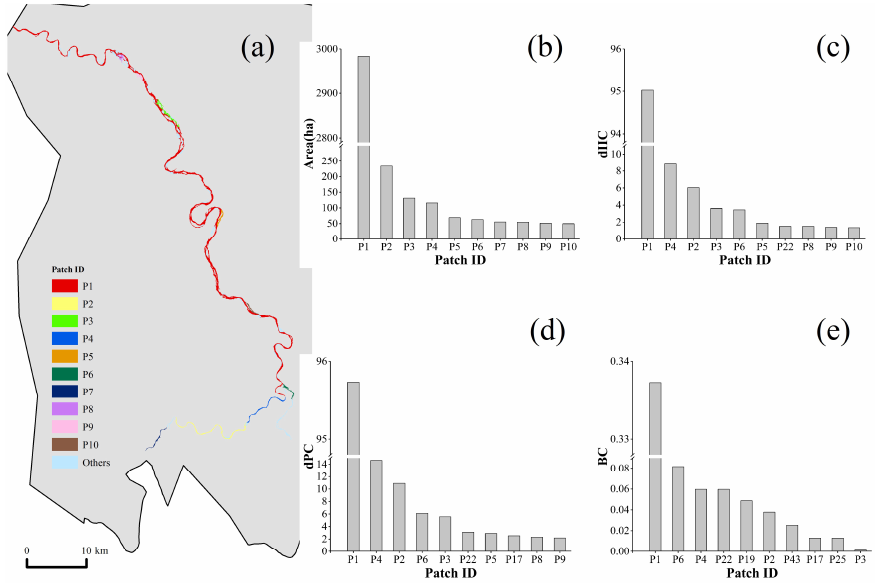
Figure A3. Statistics of different indices for the top 10 patches obtained from the results of connectivity modelling for 2000. ( a ) Distribution of patches (n), ( b ) Area of patches (ha), ( c ) dIIC, ( d ) dPC, and ( e ) BC.